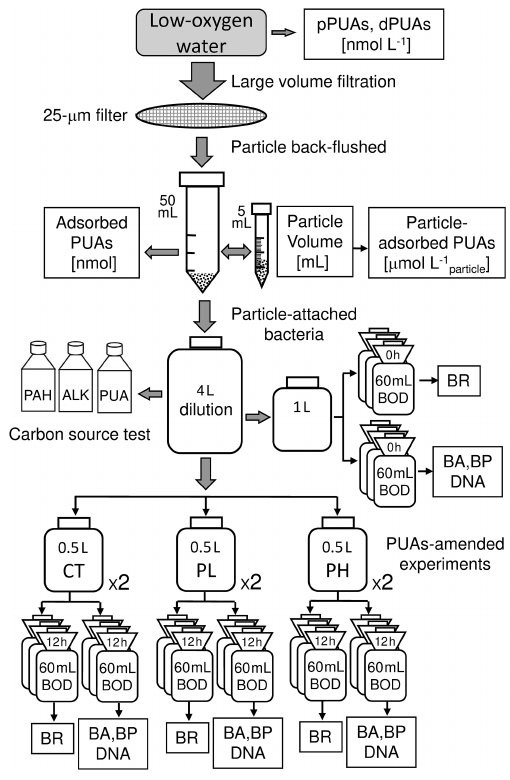
Figure 2. Procedure of large-volume filtration and subsequent ex- periments. A large volume of the low-oxygen water was filtered through a 25µm filter to obtain the particle-adsorbed PUAs and the particle-attached bacteria (PAB). The carbon-source test of PUA for the inoculated PAB includes the additions of PUA, alkanes (ALKs), and polycyclic aromatic hydrocarbons (PAHs). PUA-amended ex- periments for PAB include control (CT), low-dose (PL), and high- dose (PH) PUAs. Samples in the biological oxygen demand (BOD) bottles at the end of the experiment were analyzed for bacterial res- piration (BR), abundances (BA), production (BP), and DNA. Note that pPUAs and dPUAs are particulate and dissolved PUAs in the